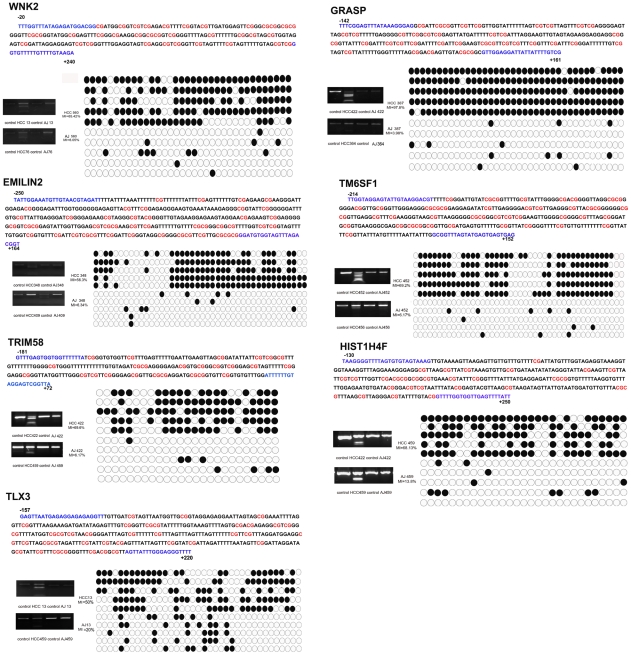
DNA methylation status of seven selected genes in HBHC and adjacent liver tissue.COBRA analysis were performed as amplified PCR of sodium bisulfite-converted genomic DNAs, PCR products incubated with BstUI to measure the methylation rate and samples without incubation with BstUI were listed as control. Selected PCR products were cloned into T-A clones and sequencing. Five samples of each alleles listed were shown by black and white circles represent methylated and unmethylated CpG dinucleotides respectively. "MI" was the abbreviation of methylation index, calculated as the percentage of the methylated dinucleotides versus total. Detail methylated sites were marked in red, the position of COBRA primers is also shown in blue, covering the region was respect to the transcription start site. AJ was the abbreviation of adjacent liver tissue.